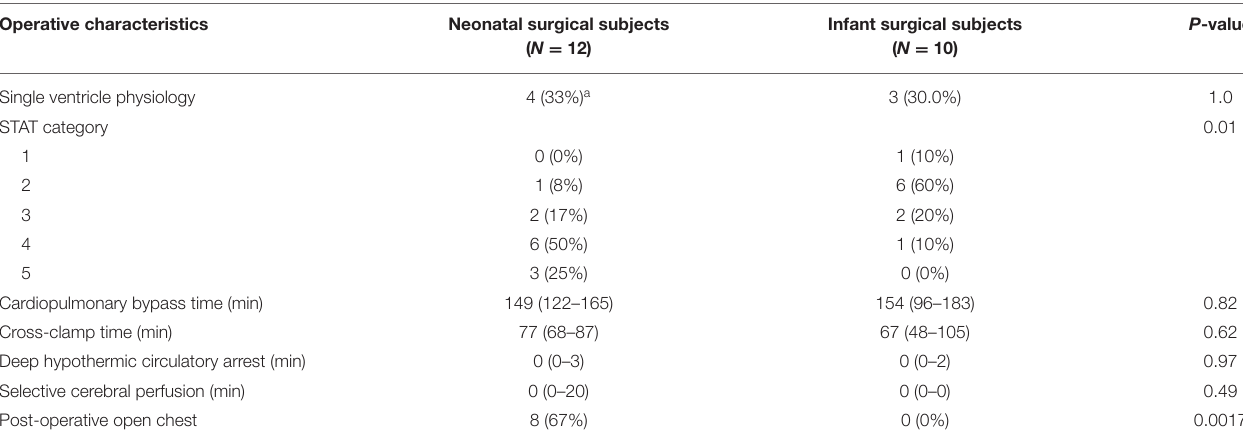
TABLE 2 | Operative characteristics of surgical